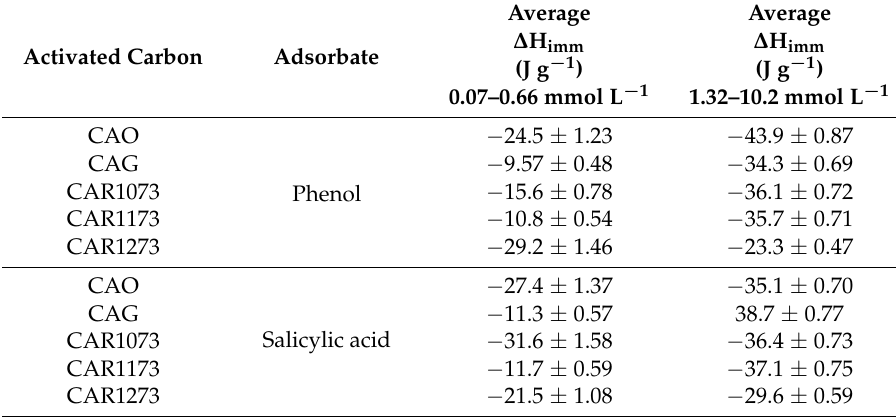
Table 14. Immersion enthalpy for the adsorption of phenol, salicylic acid, acetaminophen, and methylparaben in aqueous solution on the activated carbons CAO, CAG, CAR1073, CAR1173, and CAR1273.